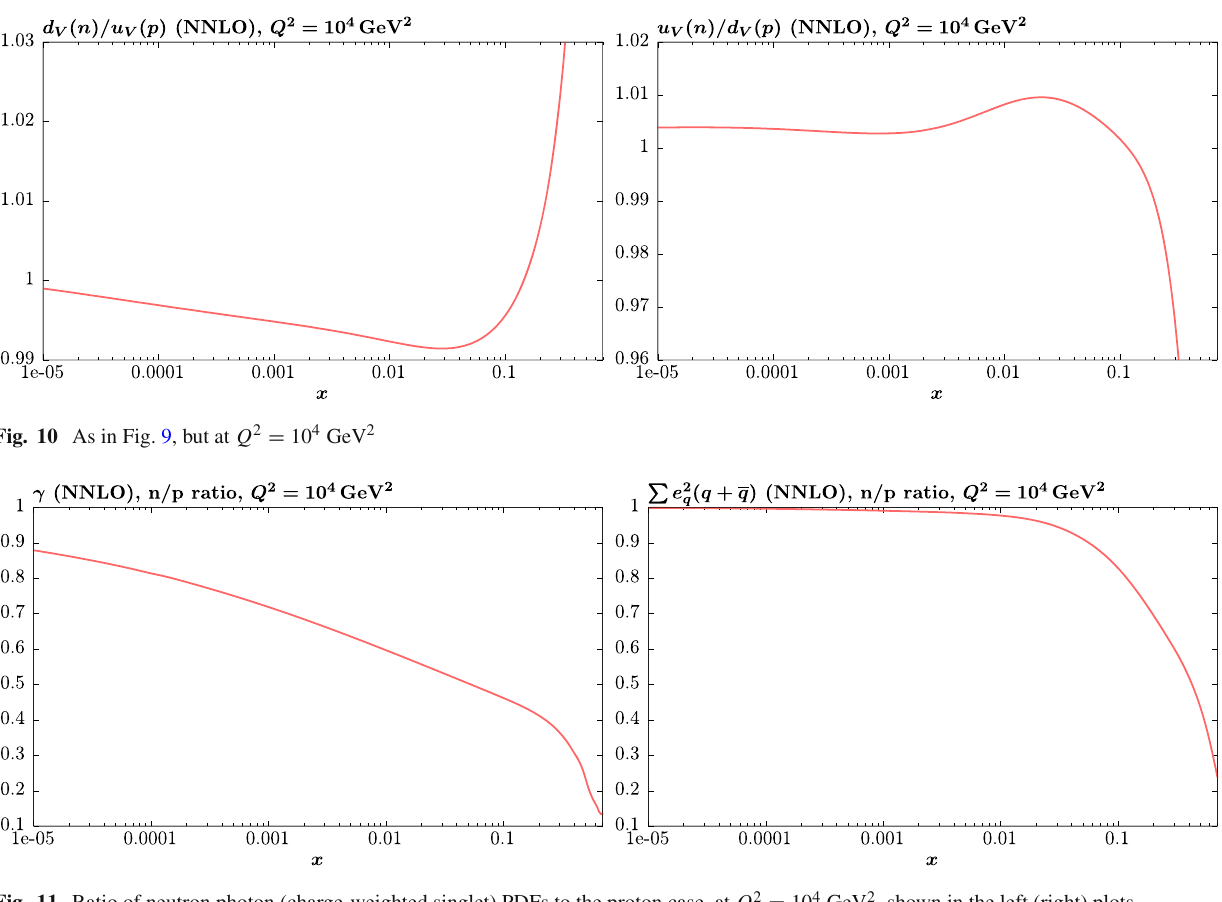
elastic and inelastic photon